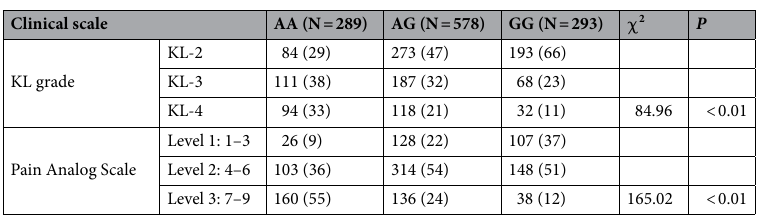
Table 4. Association between SNP rs11177 and clinical severity and pain analog scale in patients with hand OA.